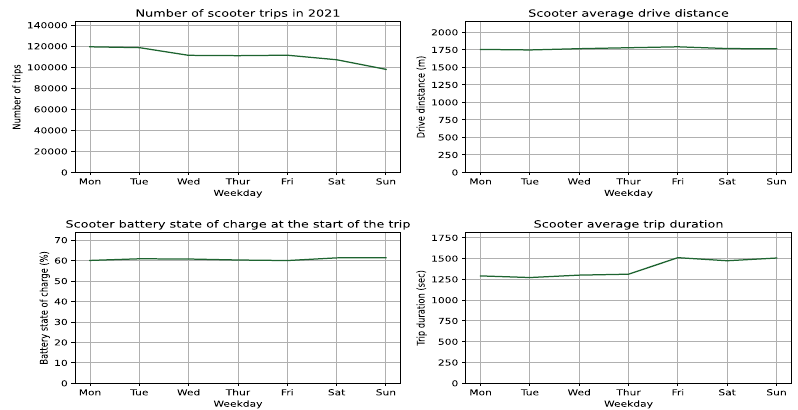
Fig. 8. Average scooter use depending on the day of the